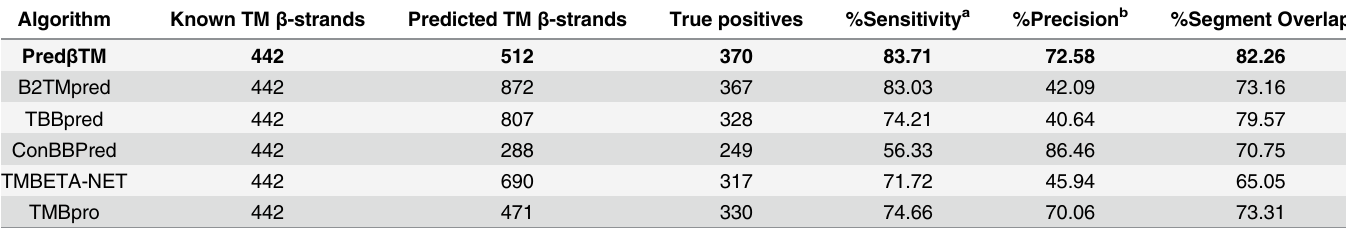
Table 1. Comparative performance analysis of the developed Pred β TM algorithm and five other available algorithms. Algorithm Known TM β -strands